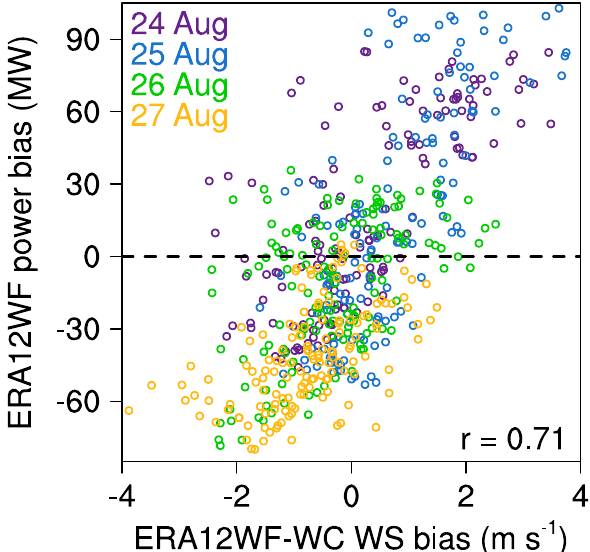
Figure 10. Scatter plot between the bias of the ERA12WF 10min total power compared to observation, and its bias of the simulated hub-height WS in the closest grid cell to the WC. The r represents the Pearson correlation